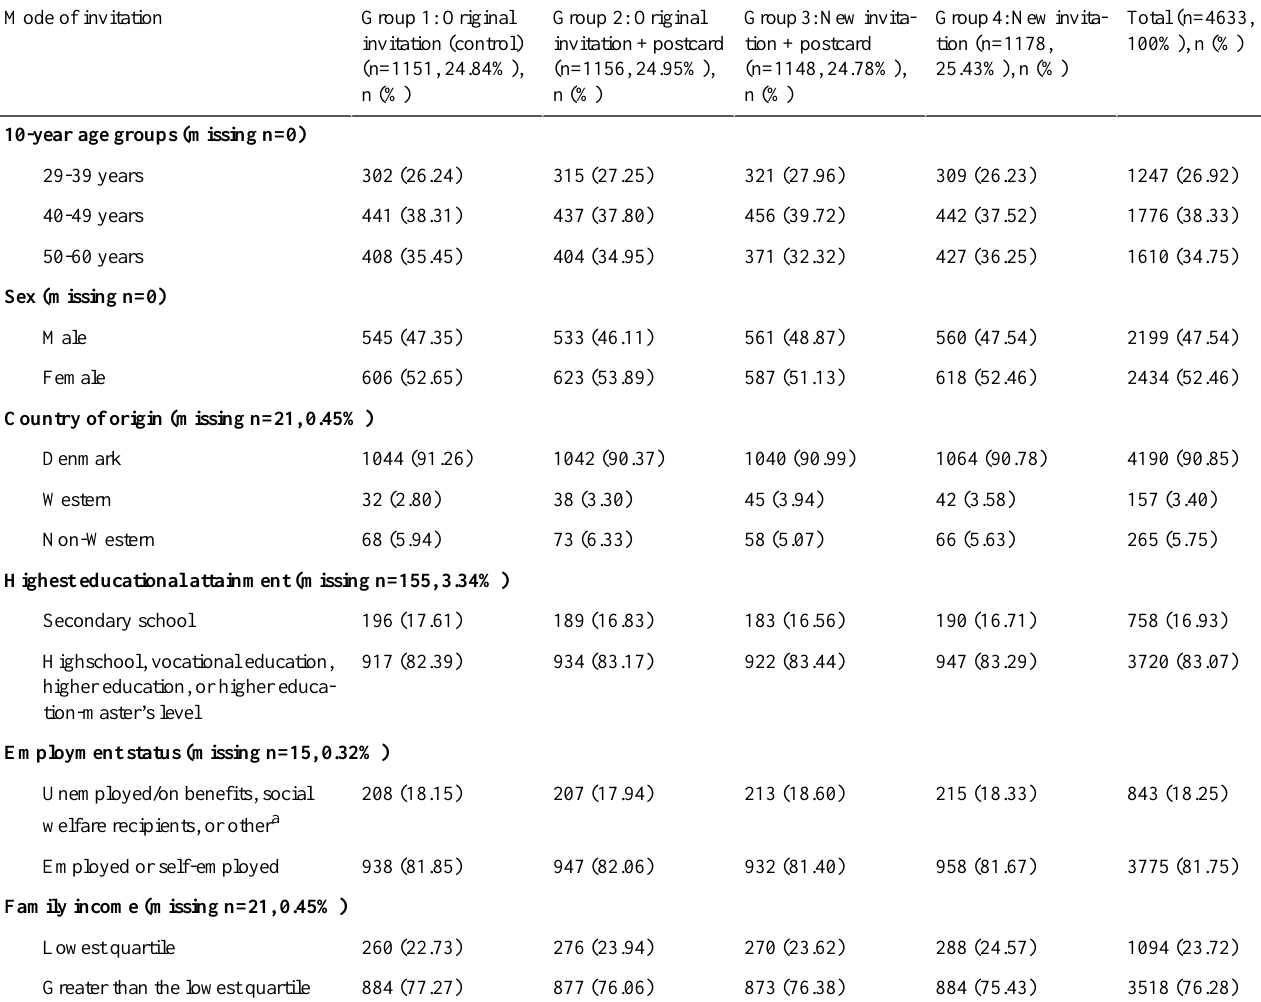
Table 1. Sociodemographic characteristics and mode of invitation among patients invited to participate in a preventive primary care program for lifestyle-related diseases (TOF